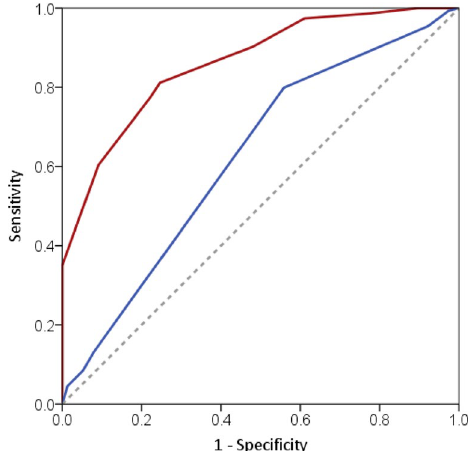
Figure 2. Receiver operating characteristic curve (ROC) analysis for the diagnosis of reversible cerebral vasoconstriction syndrome (RCVS). Data were analyzed using the validation data set. Solid red line represents the ROC of RCVS–TCH score with Area Under the Curve (AUC) of 0.861 (95% CI = 0.815–0.908). Solid blue line represents the ROC of RCVS 2 score with AUC of 0.601 (95% CI = 0.526–0.677). Diagonal dashed line us a reference line (AUC =